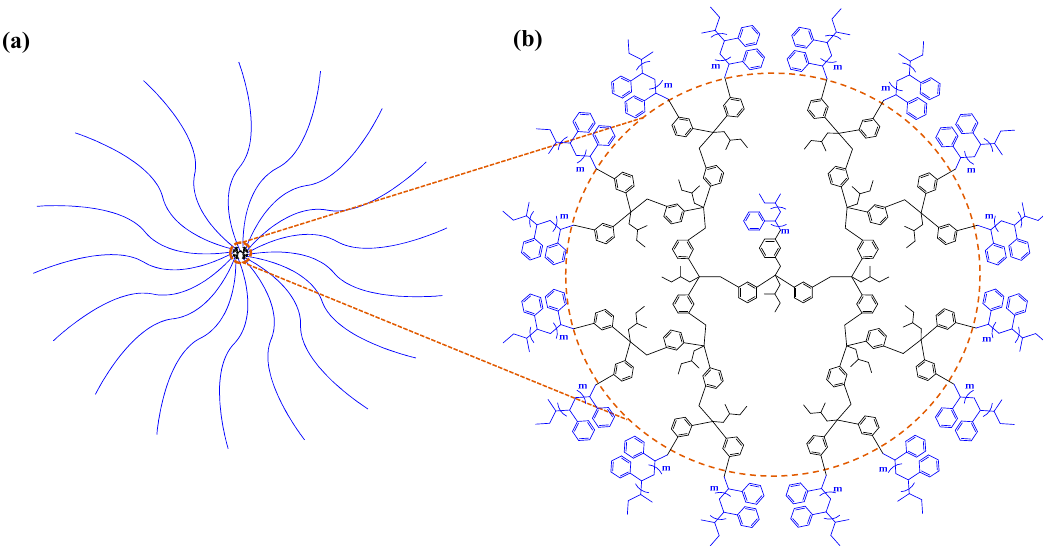
Figure 1. Chemical structure and characteristics of 17-armed star polystyrene: ( a ) schematic molecular structure representation; ( b ) chemical structure detail, which is composed of a dendritic core and 17 polystyrene arms. Table 1. Molecular characteristics and thermal properties of 17-armed star